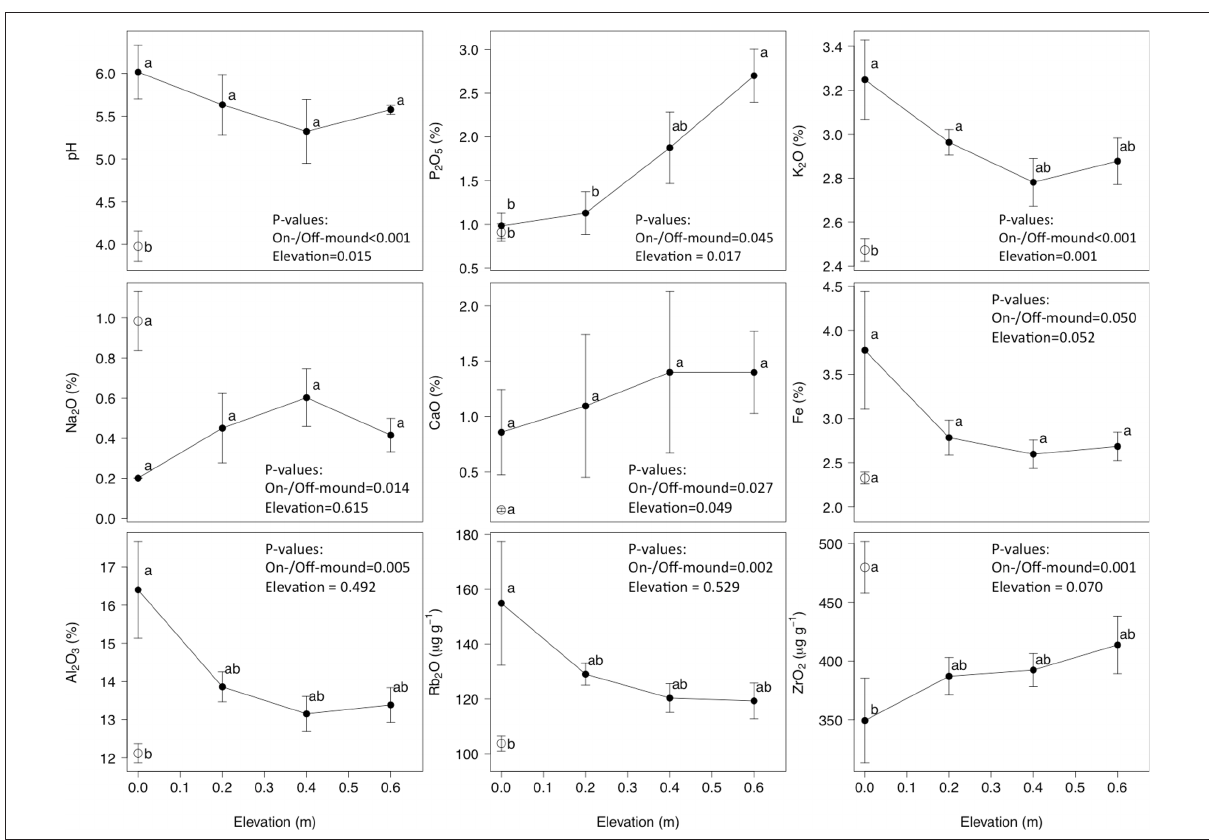
Figure 6:. The variation of soil pH and elemental concentrations between the on- and off-mound sites and with elevation in the mound profile above the duripan layer. The error bars indicate the standard error ( n =5) and different letters indicate significant ( p <0.05) differences as determined by ANOVA followed by post-hoc Tukey tests. The p -values in each panel are for the general linear model in which site (on- or off-mound) was a categorical predictor and elevation within mound a continuous